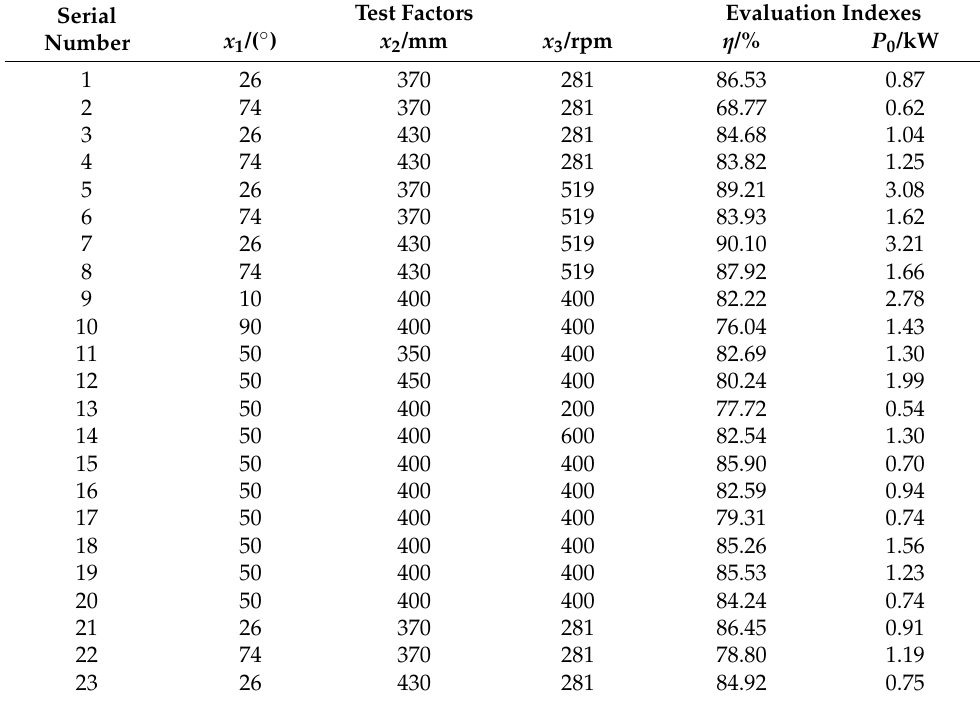
Table 2. Test scheme and